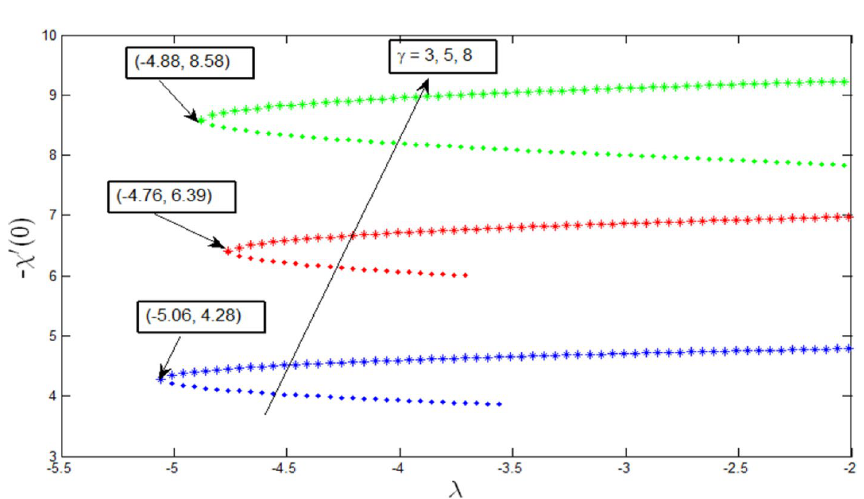
′ ( 0 ) with (cid:31) for various values of γ when